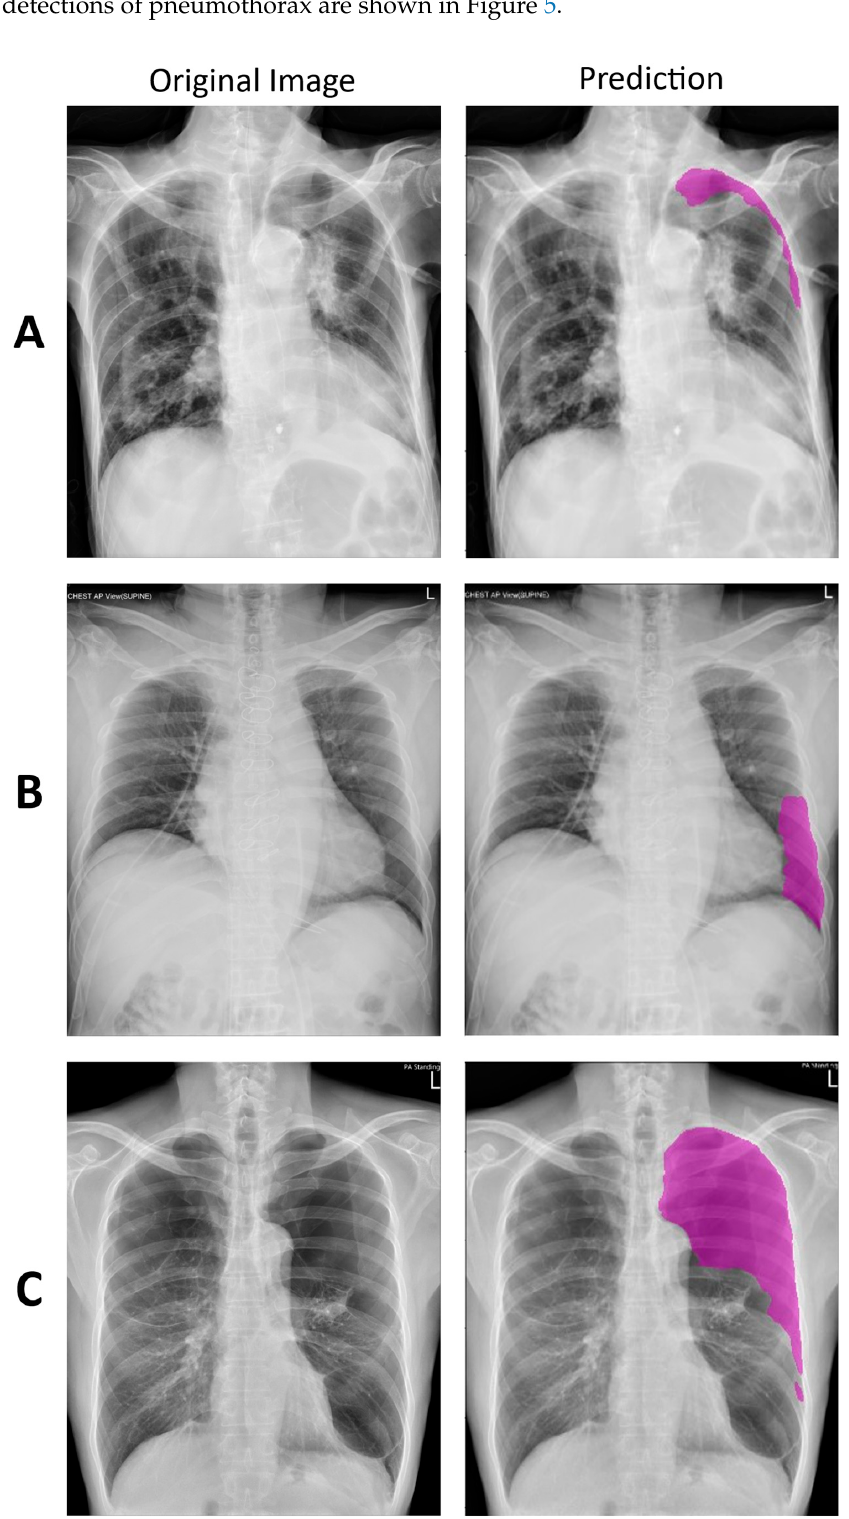
Figure 5. Examples of false-positive detections of pneumothorax with predicted area along ribs ( A ), heart border ( B ), and bullae ( C ). The predicted areas are shown in purple.